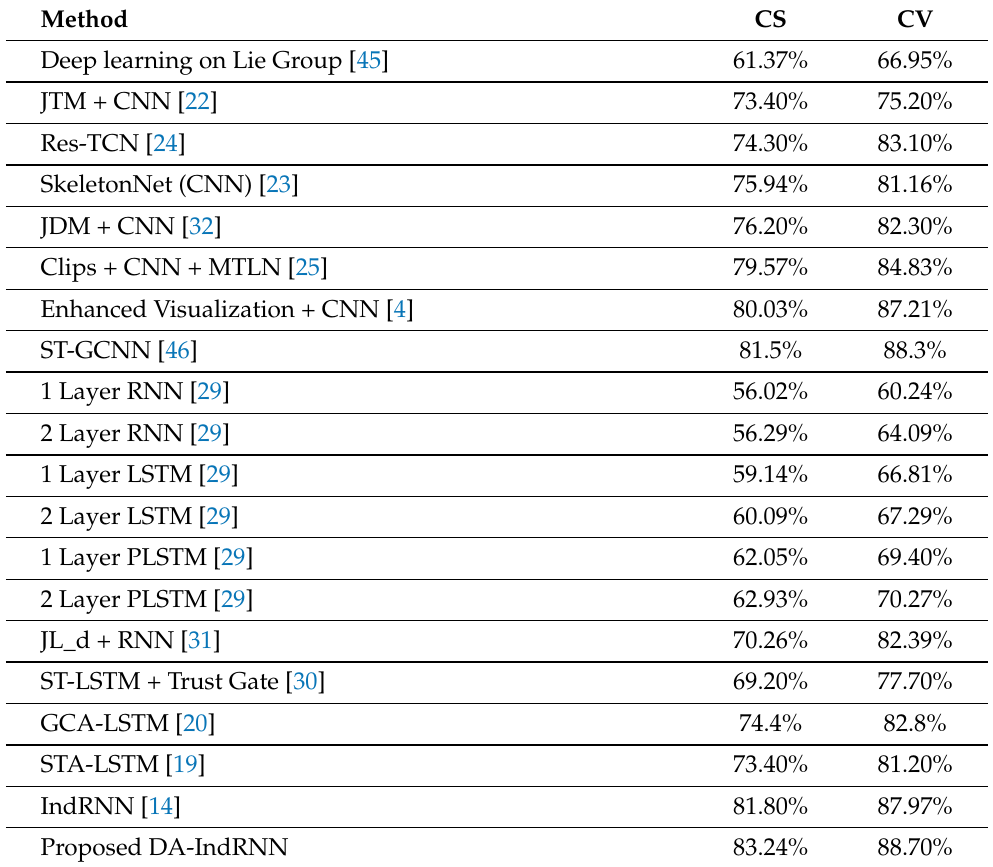
Table 1. Results of the skeleton-based action recognition on NTU RGB + D dataset in comparison with the existing